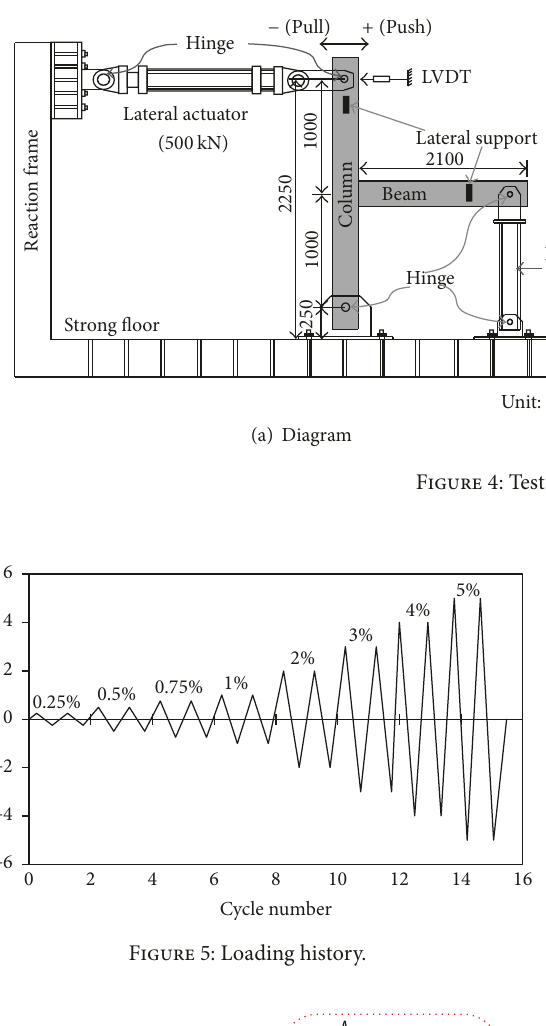
Figure 5: Loading history.